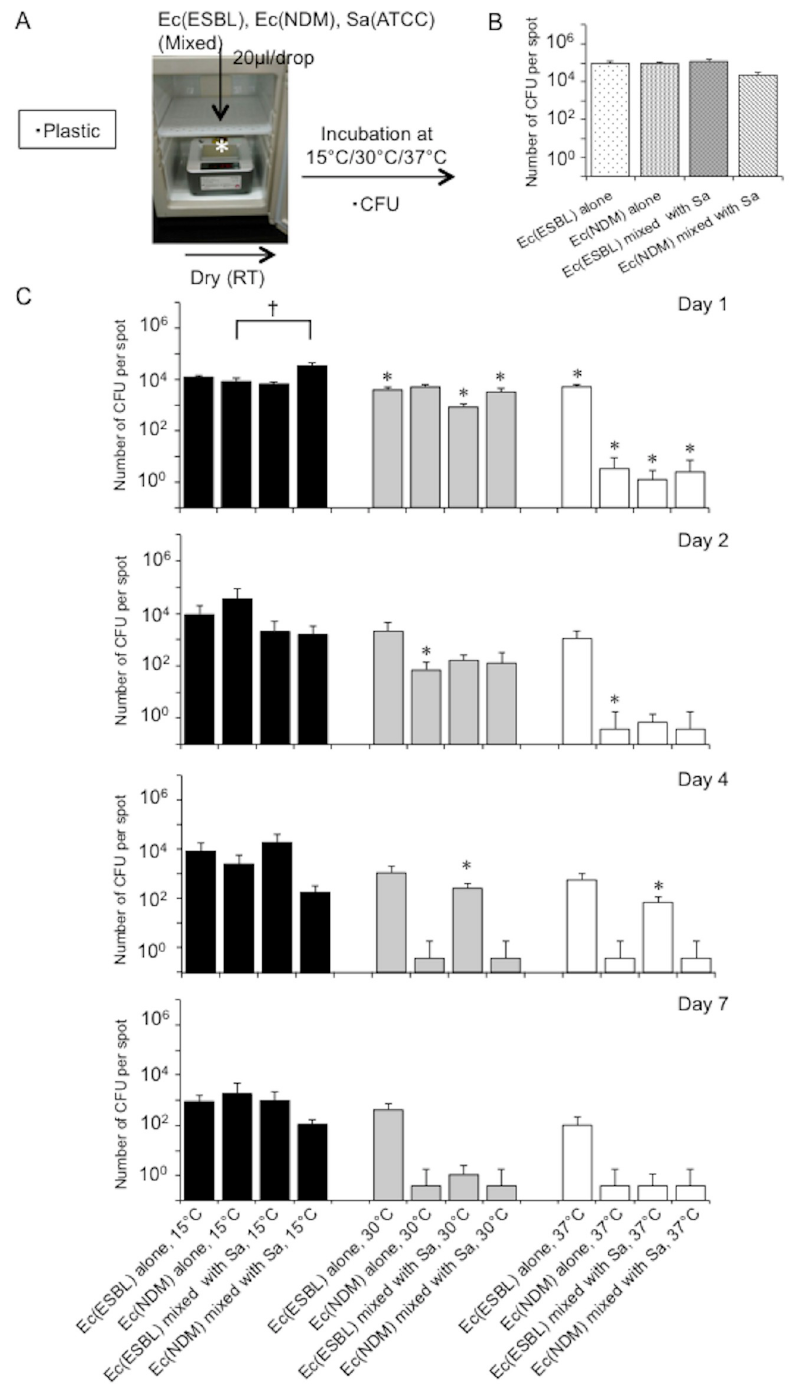
Fig 4. Representative multidrug-resistant bacteria also favor lower temperatures for their survival on plastic surfaces. A . Experimental protocol. Bacterial survival was monitored for mixed or single bacteria on plastic surfaces at distinct temperatures (15˚C, 30˚C, 37˚C) for 11 days by a CFU assay (CFU). Ec (ESBL), ESBL-producing E . coli . Ec (NDM), NDM-producing E . coli . Sa, S . aureus (ATCC 29213). B . Bacterial numbers immediately (within 20 min) after drying. Ec (ESBL), ESBL-producing E . coli . Ec (NDM), NDM-producing E . coli . Sa, S . aureus (ATCC 29213). C . Changes in bacterial numbers at distinct temperatures (15˚C, 30˚C, 37˚C) over 11 days, as determined by a CFU assay. Ec (ESBL), ESBL-producing E . coli . Ec (NDM), NDM-producing E . coli . Sa, S . aureus (ATCC 29213). � , p < 0.05 vs. the values at room temperature. †, p < 0.05 between the